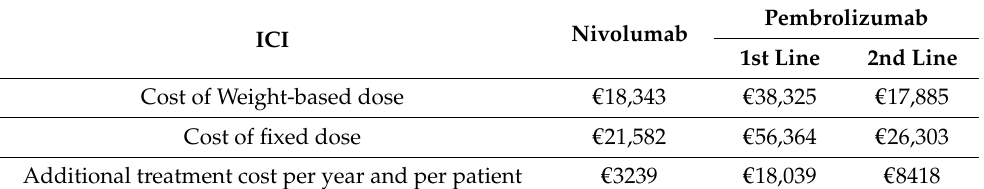
Table 5. Annual additional cost per patient and per molecule of the fixed dose compared to the weight-based dose.